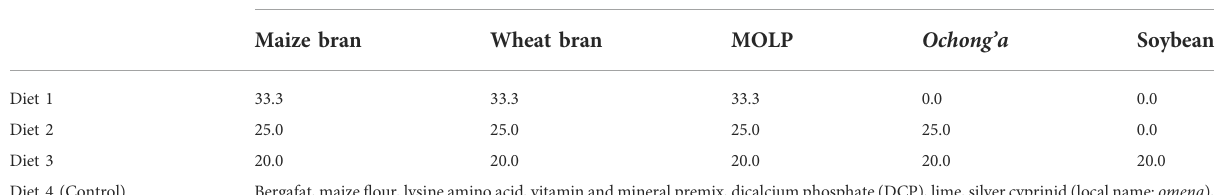
TABLE 1 Composition of the diets used to assess development, survivorship, longevity, and reproductive performance of Ruspolia differens